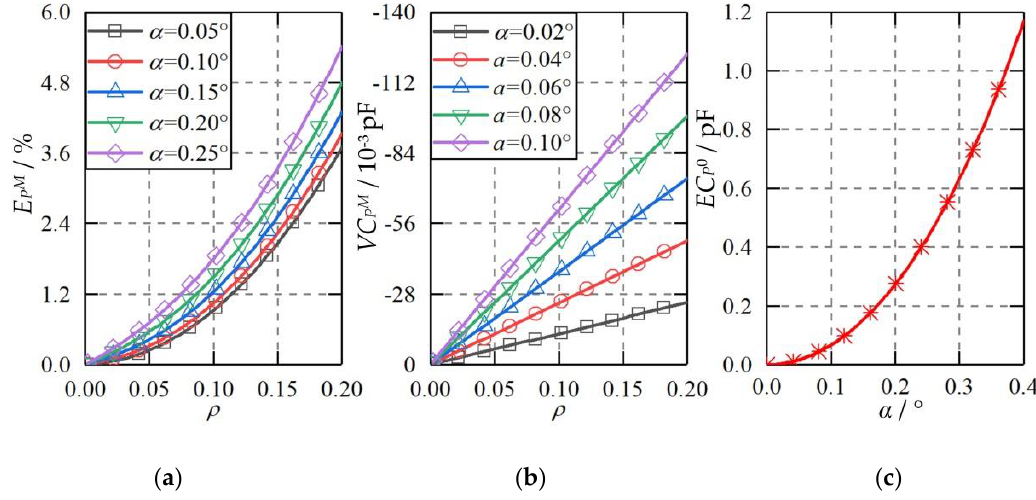
Figure 18. The theoretical capacitance error when CP S1 is inclined with an angle to the ideal position. ( a ) Higher-order capacitance error, ( b ) variable capacitance error, ( c ) constant capacitance error.